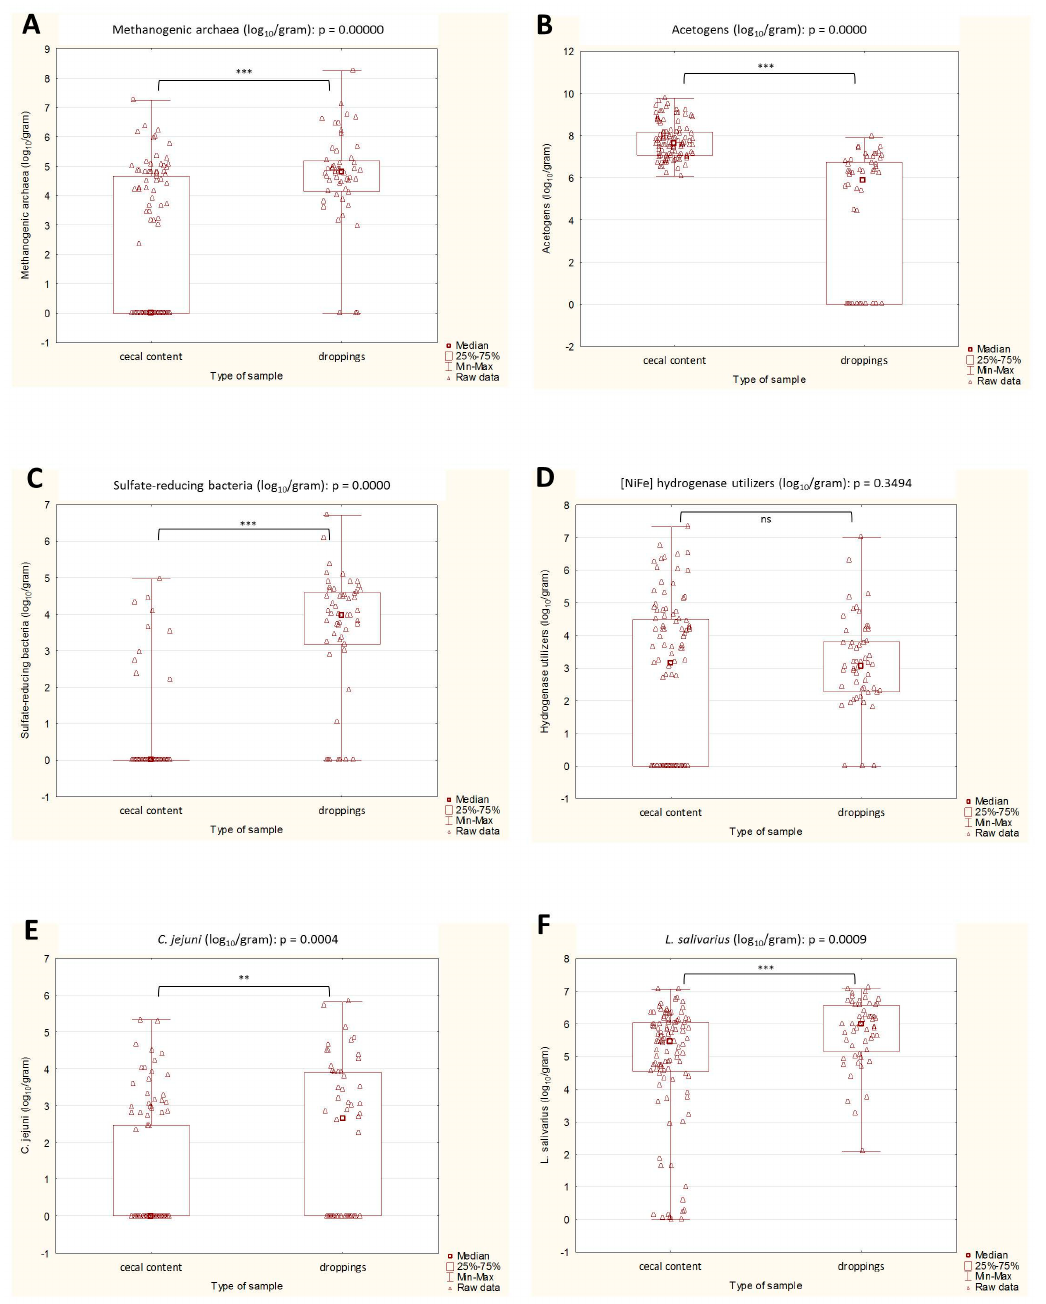
Figure 1. ( A – F ). Box plots representing the abundance of selected microbial groups in ceca and excreta samples. Statistical significance between cecal contents and excreta is marked by asterisks. Values of ** p < 0.01, and *** p < 0.001 were regarded as significant; ns: non-signi fi cant.